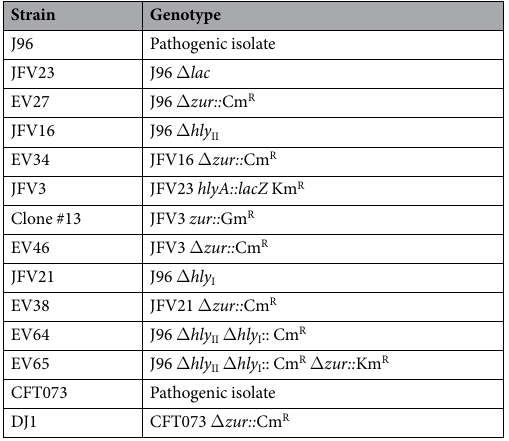
Table 1. Strains used in this